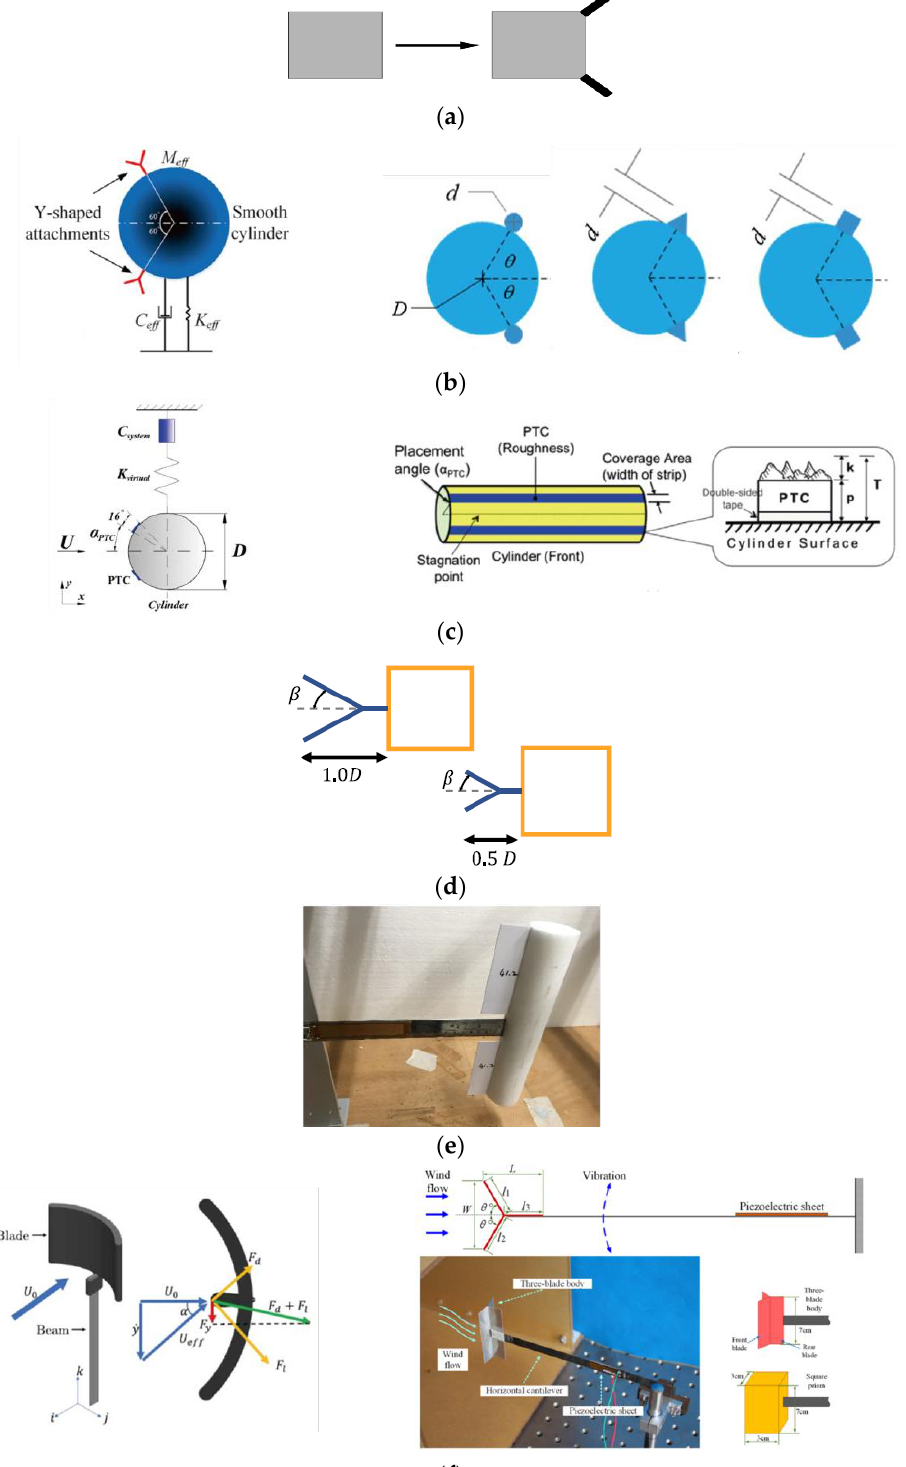
Figure 1. The aerodynamic shapes of optimized galloping bluff bodies, such as ( a ) square prism with leading-edge fins; ( b ) circular cylinder with different shape attachments; ( c ) circular cylinder with roughness strips; ( d ) square prism with Y-shaped fins near the trailing edge; ( e ) circular cylinder with a splitter plate; ( f ) blade bluff bodies.